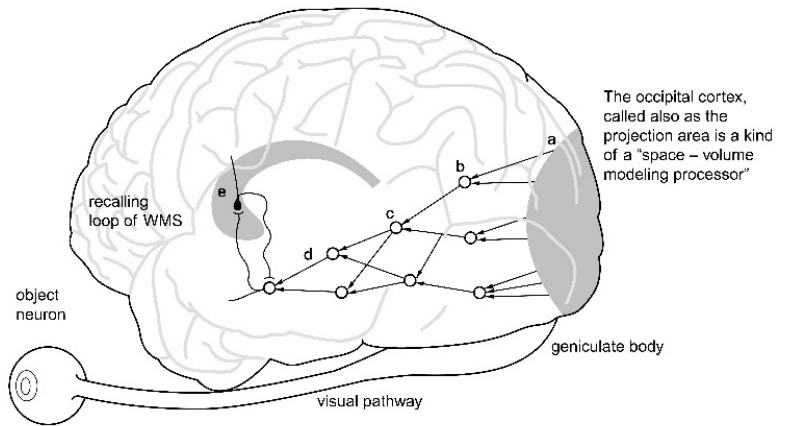
Figure 1. Diagram of the visual pathway, showing the location of object neurons and their relationship to memory systems. The diagram illustrates that the hierarchical neural structure, integrating visual information runs first to the occipital lobe, but is prolonged by afferent pathways in the temporal lobe, where so called ‘object neurons’ are located. The object neurons can be activated from the side of the speech area or by the loops of the working memory system.